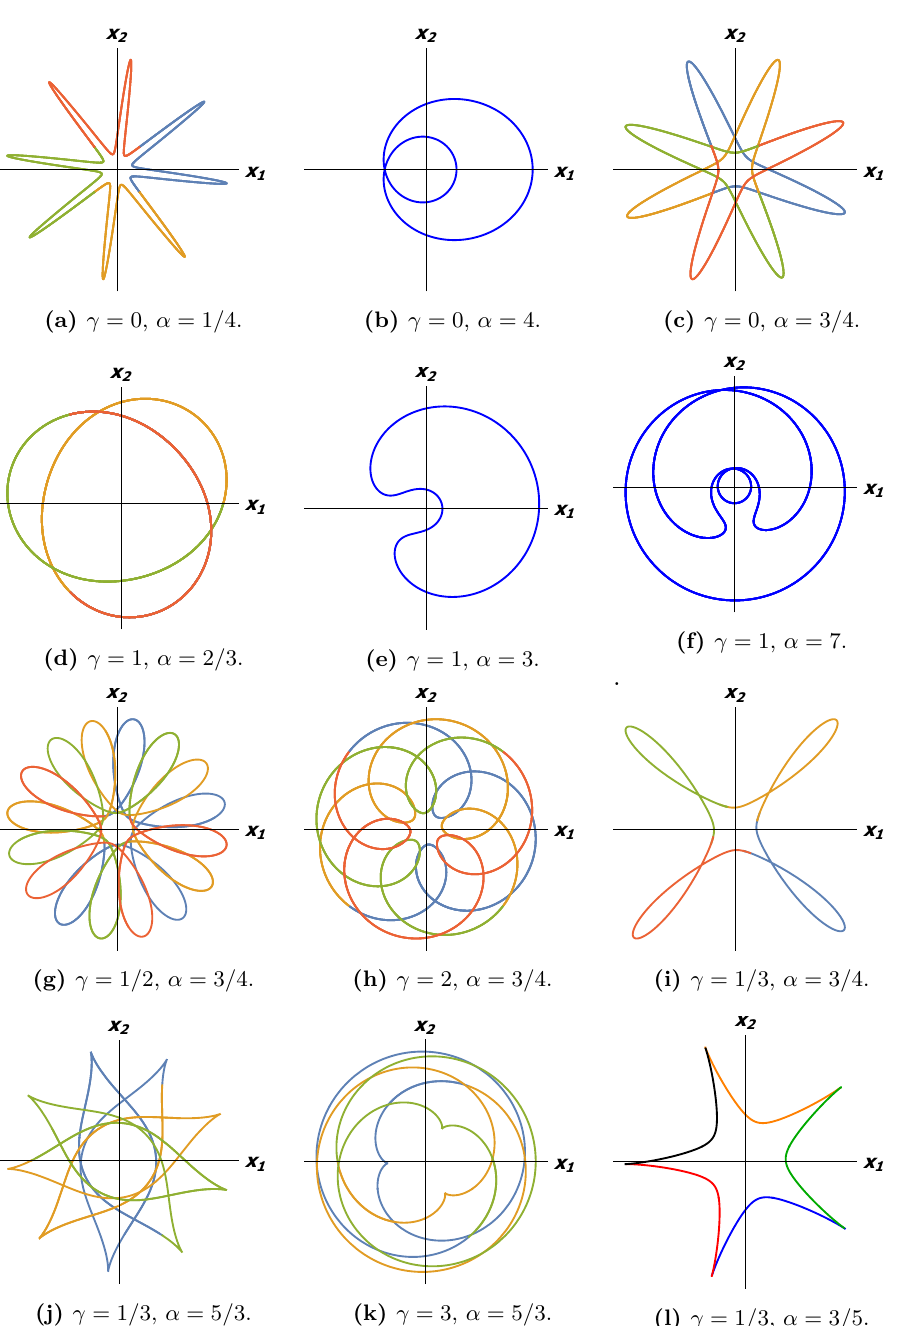
Figure 2. Trajectories for some values of the parameters α and γ . Different colours in the same orbit indicate different branches for the angular variable ϕ ( t ) according to (3.17). Figures 2d, 2e and 2f correspond to examples of the Landau phase γ = 1 . In figure 2d the trajectory encloses the origin of the coordinate system (here, R 1 > R 2 and the total change for the period is ∆ ϕ = 4 π ), contrary to the cases of 2e and 2f (in which ∆ ϕ = 0 and R 1 < R 2 ). The last three figures correspond to the trajectories with cusps that occur in the case R 1 | ‘ 1 | = R 2 | ‘ 2 |